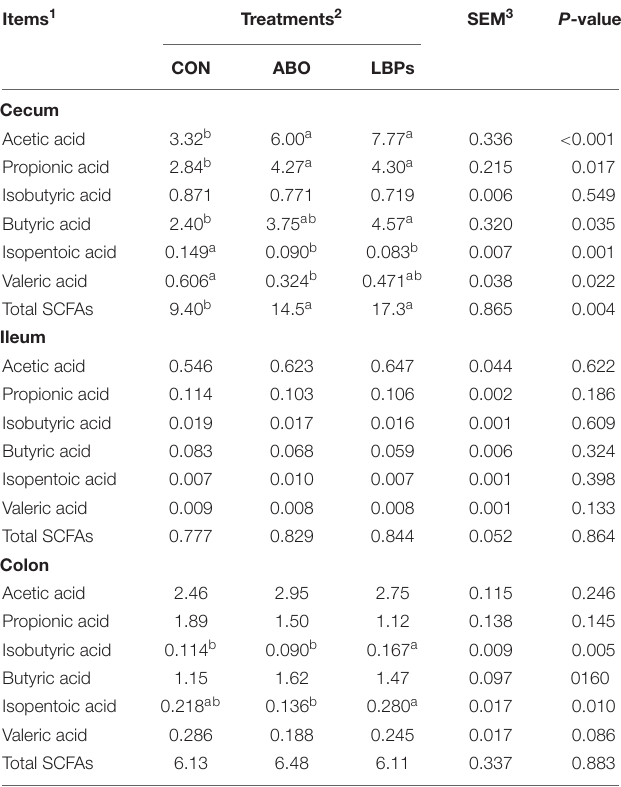
TABLE 7 | Effects of dietary LBPs supplementation on short-chain fatty acids in intestinal contents of weaned piglets ( µ g/kg). Items